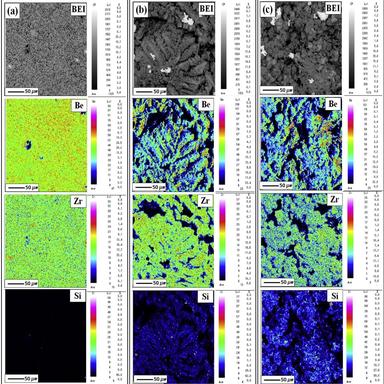
Area analyses of pebbles with (a) 1%Si, (b) 5%Si, and (c) 10% Si by the EPMA.